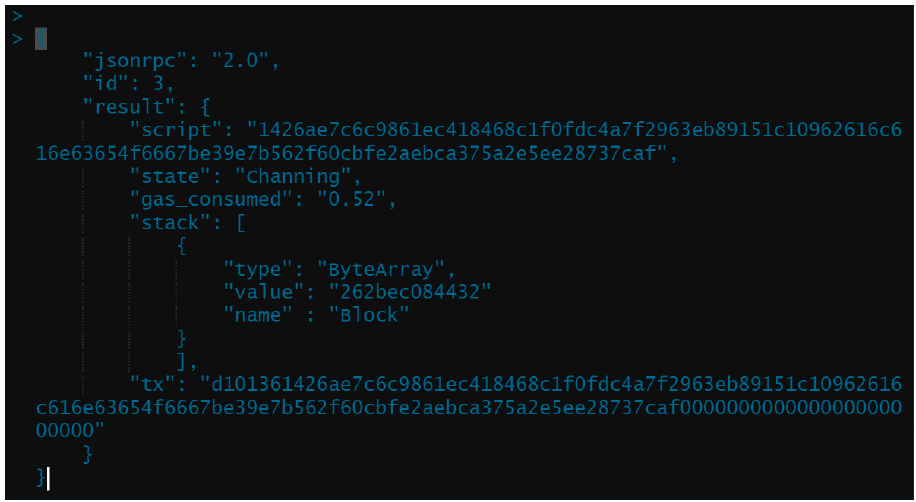
Figure 9. Verification source code for block channing.